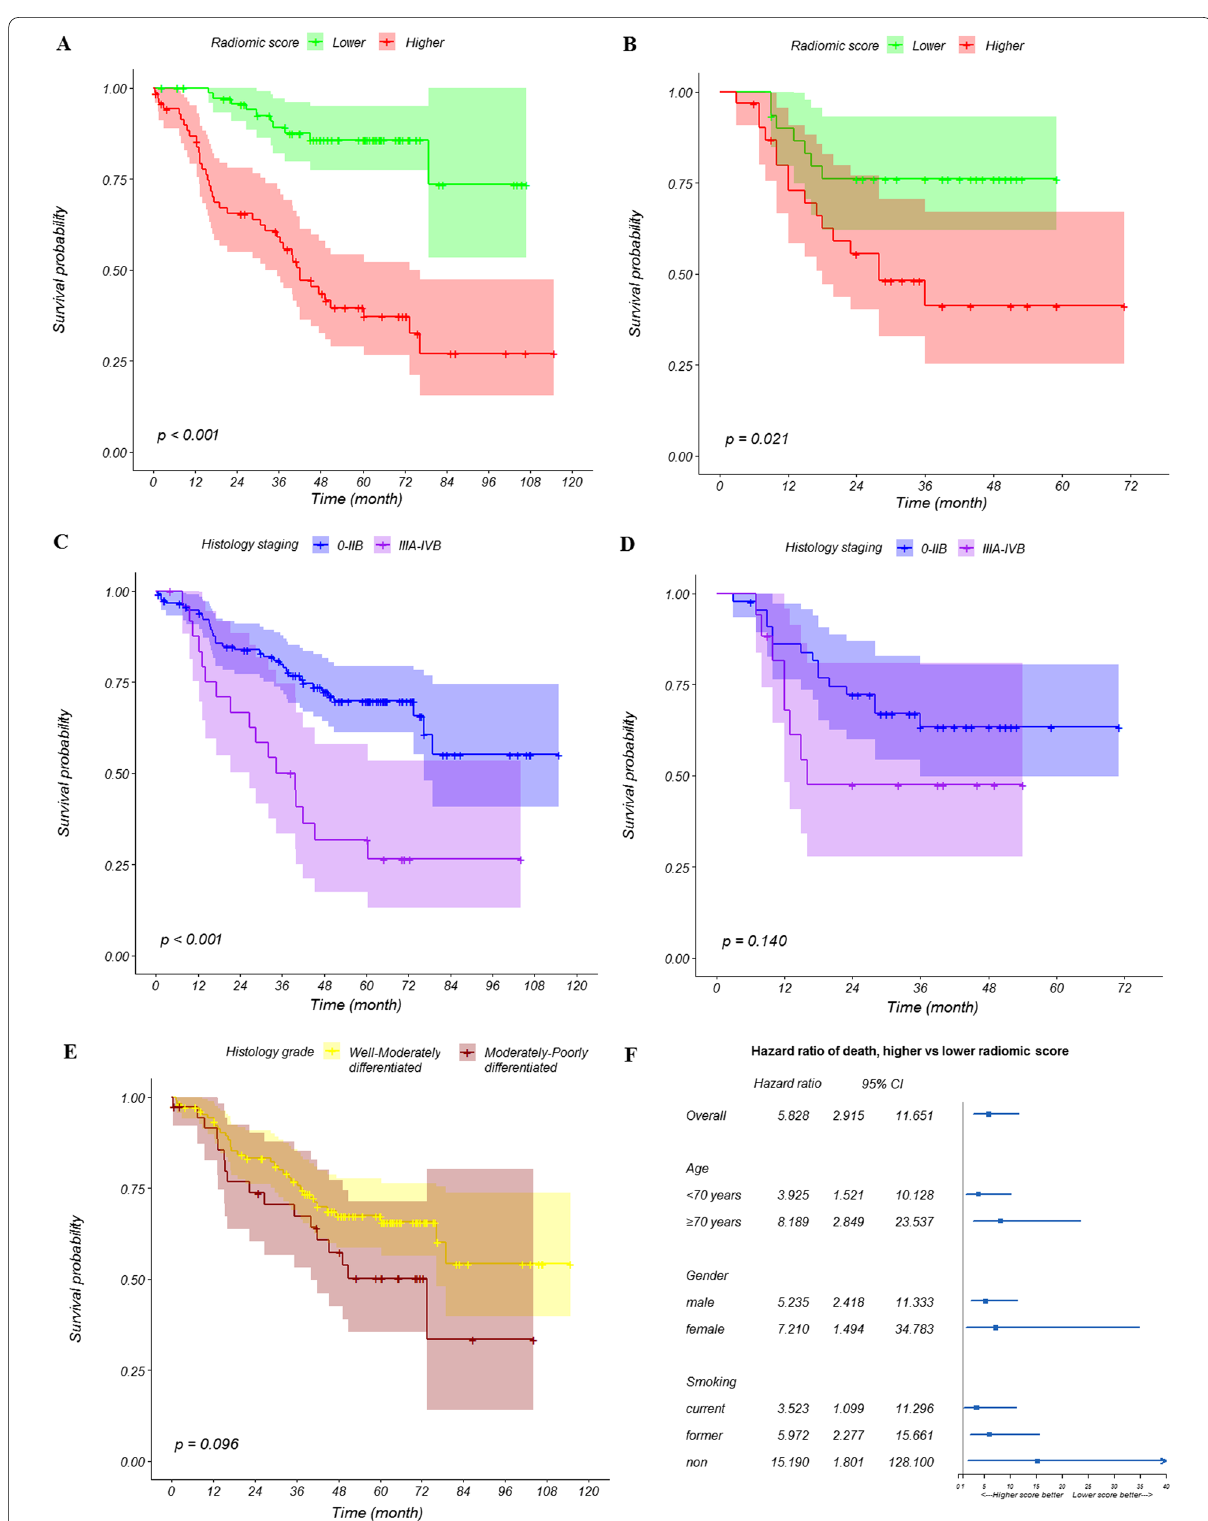
Fig. 1 Survival of lung cancer patients. Stratified by composite radiomic score, ( A ) Cohort A, ( B ) Cohort B; histopathological staging, ( C ) Cohort A, ( D ) Cohort B; histopathological grading, ( E ) Cohort A (data not available for Cohort B); and by demographic subgroups for the examination of score value, ( F ) Cohort